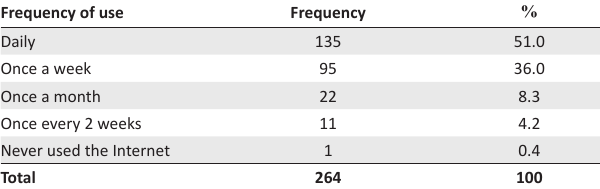
TABLE 4: Frequency of using the Internet.